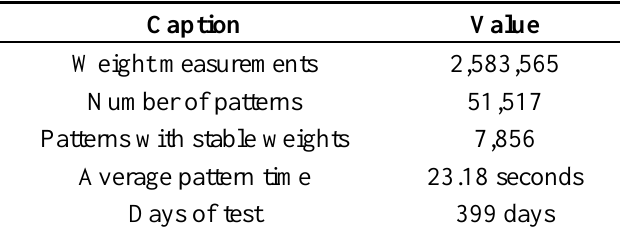
Table 2. Analysis of the